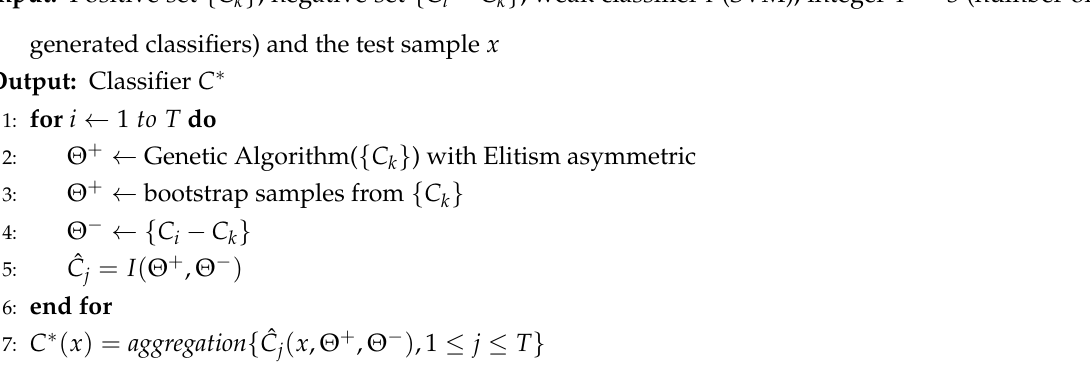
Algorithm 2 Asymmetric bagging based on elite parents through GA for SVM